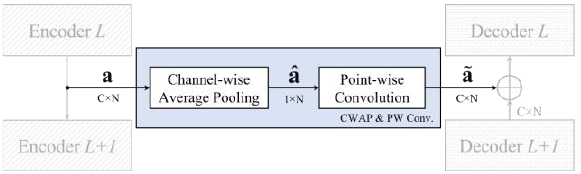
Figure 7. Channel-wise average pooling layer structure and point-wise convolution operation.